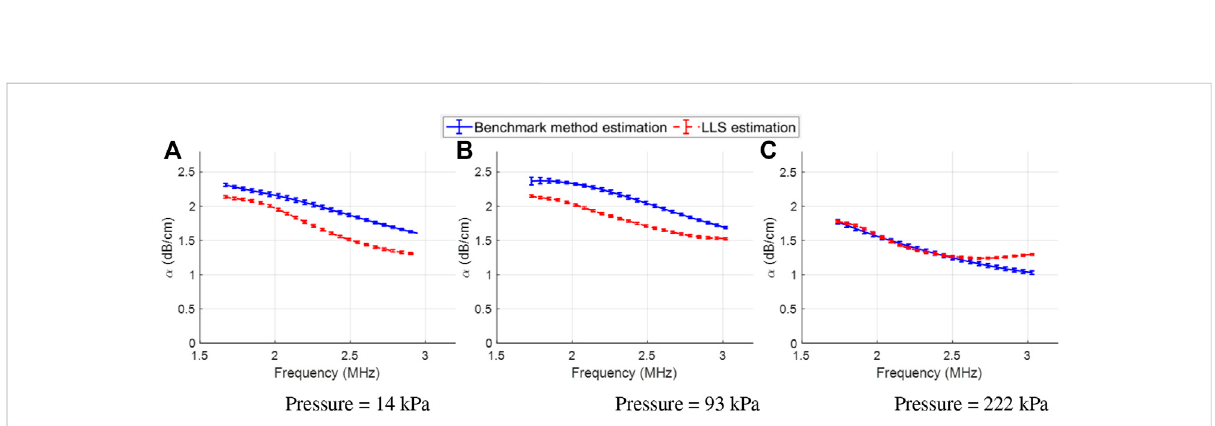
FIGURE 9 Experimentally obtained benchmark (blue curves) and LLS estimated (red curves) attenuation spectra for the SonoVue bubbles, at varying acoustic pressures (column-wise): (A) Pressure = 14 kPa, (B) Pressure = 93 kPa, and (C) Pressure = 222 kPa. For both benchmark and LLS estimated curves, the shown curves are the mean results computed across all the channels in the array, with errorbars denoting the standard